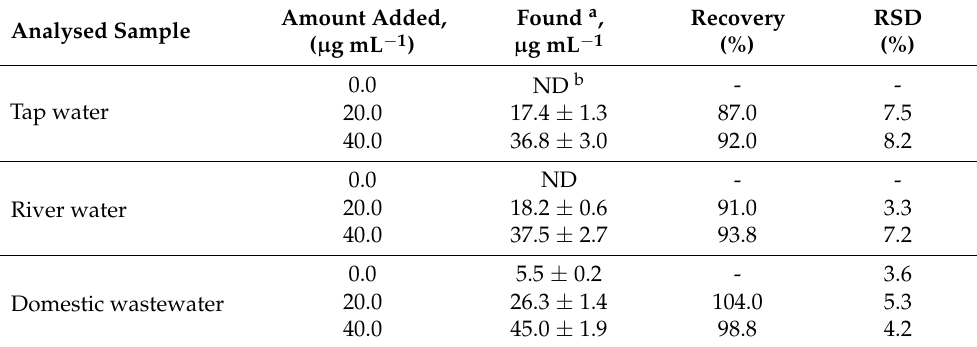
Table 8. Analysis of CTAB in spiked tap, river, and domestic wastewater samples using the developed Cu-PCV flow injection procedure.